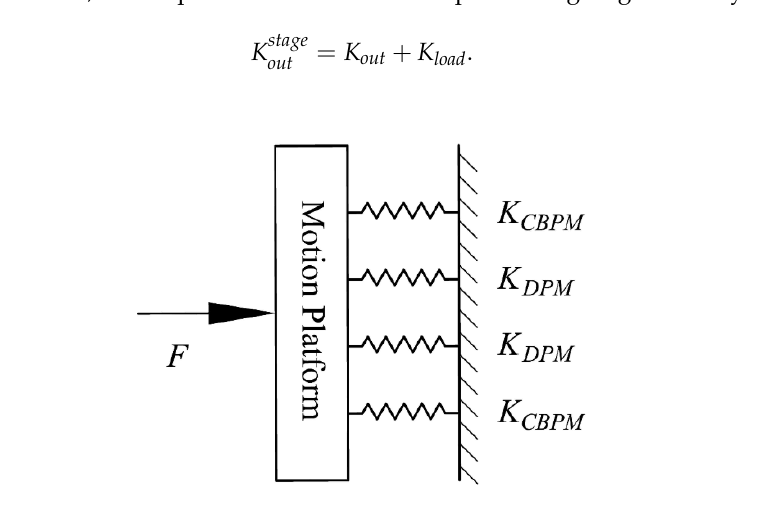
Figure 10. Equivalent stiffness model of the motion platform.